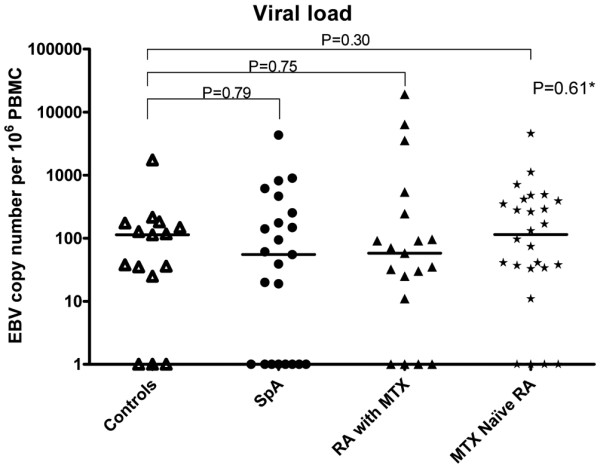
Epstein-Barr virus load in peripheral blood mononuclear cells in the cross-sectional study. Epstein-Barr virus (EBV) load distribution in control individuals (n = 15), spondylarthropathy (SpA) patients (n = 23), rheumatoid arthritis (RA) patients receiving methotrexate (MTX) (n = 18) and RA patients not receiving disease-modifying anti-rheumatic drug therapy (n = 26). Mean values of EBV viral load are represented by a black line. *Kruskall-Wallis test. PBMC, peripheral blood mononuclear cell.